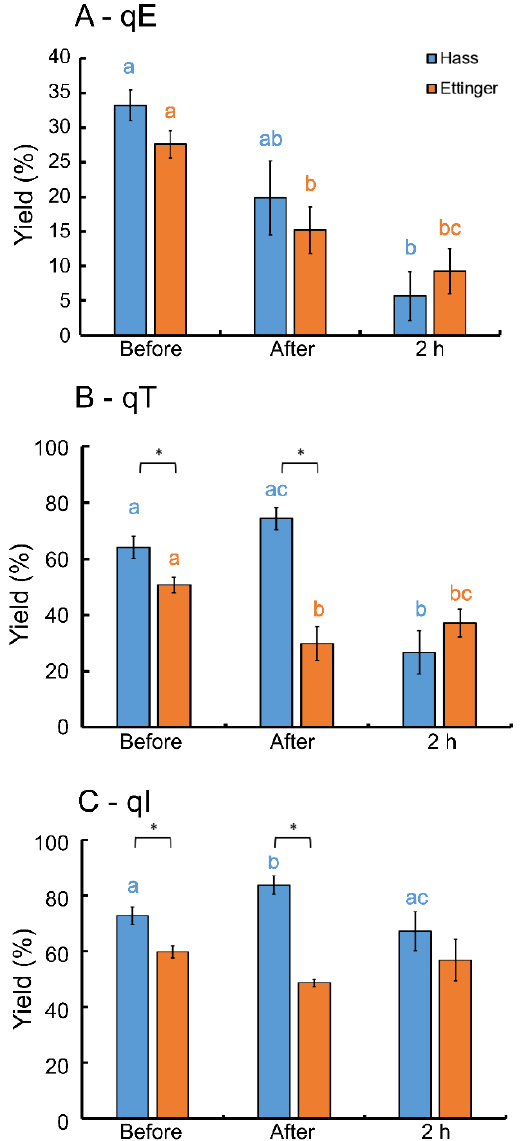
Figure 2. Quantum yield of the photoprotective mechanisms of two cultivars of avocado during cold stress. Panels ( A – C ) represent energy-dependent quenching (qE), State transition-dependent quenching (qT) and photoinhibition-dependent quenching (qI), respectively. The colors blue and orange represent the two cultivars Hass and Ettinger, respectively. N = 6, error bars represent standard error of the mean. Brackets pointing down with asterisks represent a statistically significant difference between the two cultivars on the respected time instance. Colored letters with annotation present statistically significant difference between time points for each cultivar. Statistical significance was determined at p < 0.05.